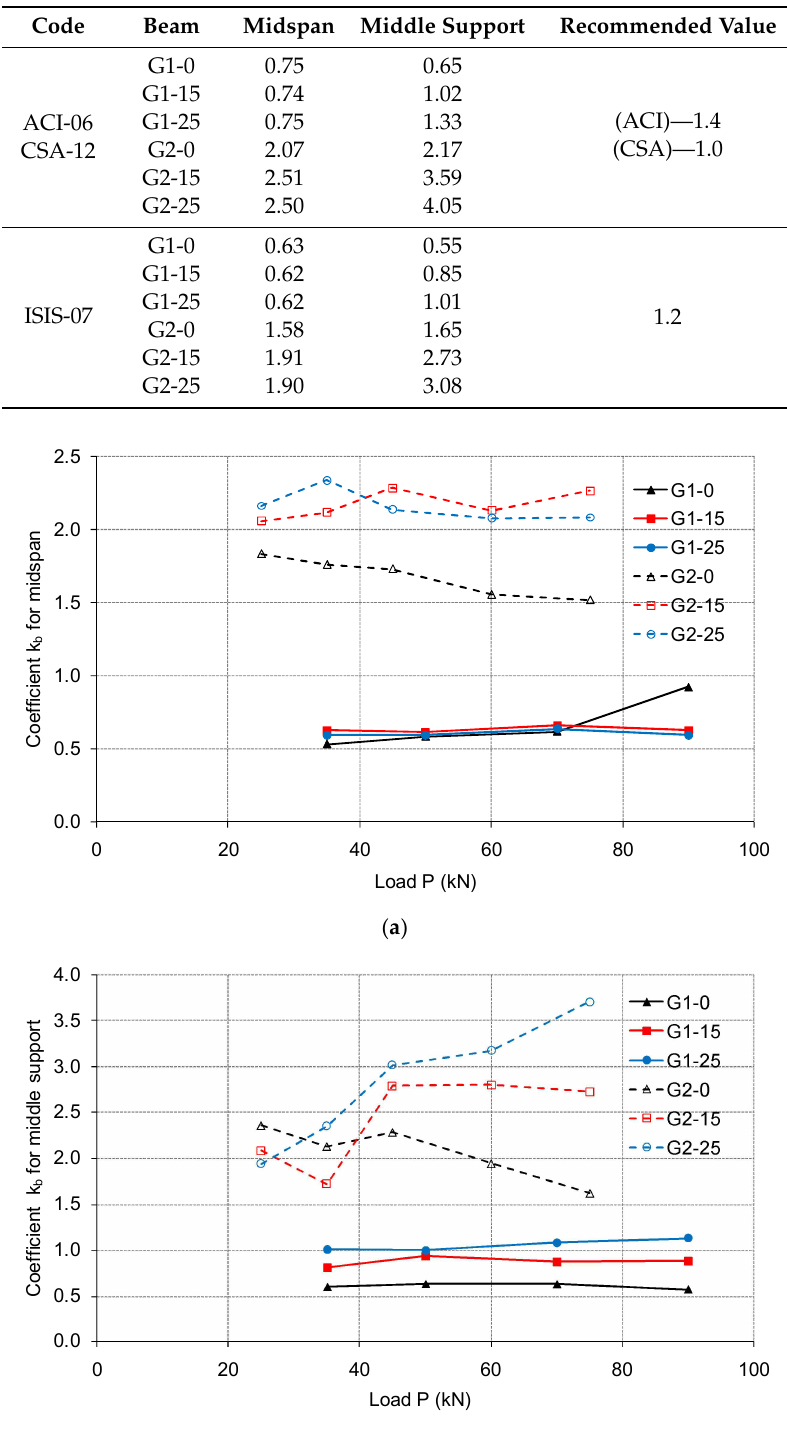
Table 3. Coe ffi cient k b for GFRP bars in the tested beams.